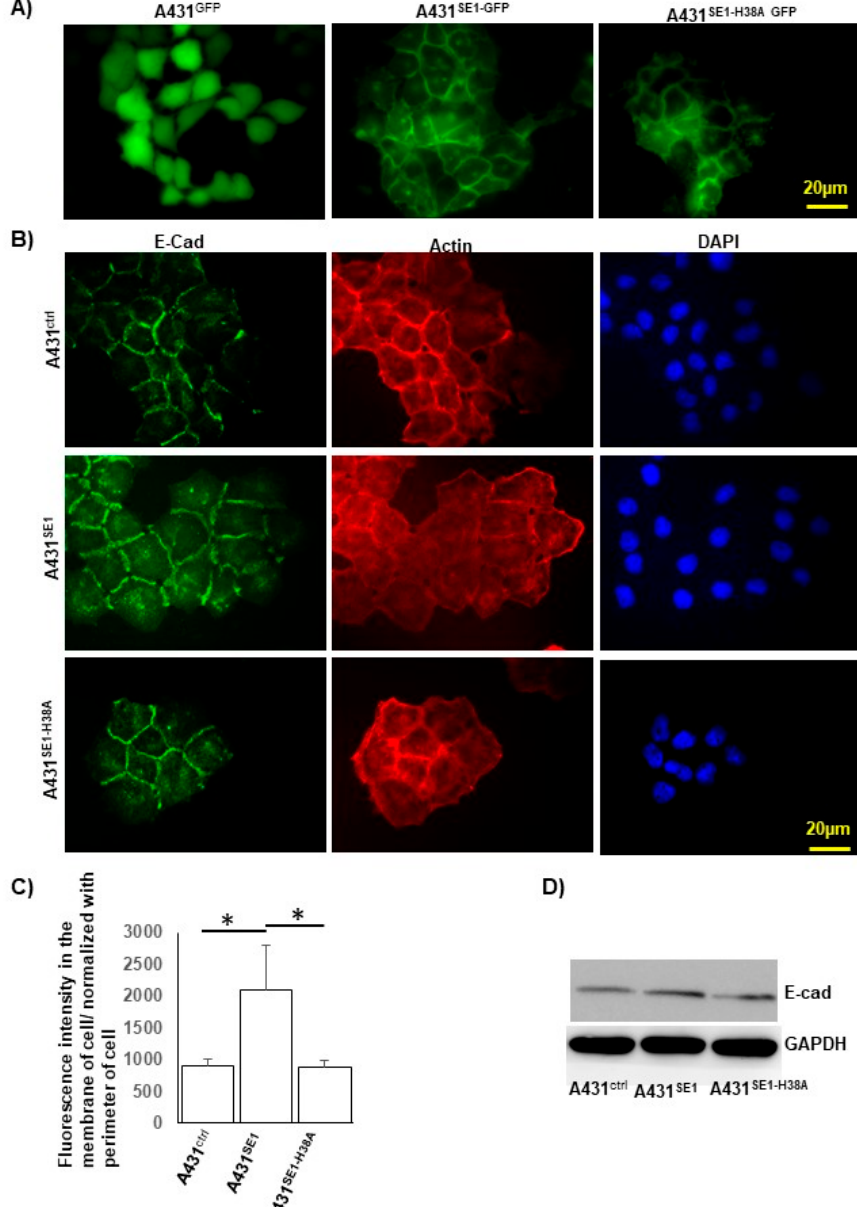
Figure 5. CDC42SE1 localizes at the plasma membrane and enhanced E-cadherin localization to the membrane in A431 SE1 cells. ( A ) A431 cells were infected with lentivirus harboring expression cassette for CDC42SE1-GFP, CDC42SE1 H38A –GFP, and GFP. The infected cells were visualized using a Olympus fluorescent microscope fitted with 40X oil objective. ( B ) A431 Ctrl , A431 SE1 , and A431 SE1-H38A cells were seeded on coverslips, grown to 40% confluency, fixed, and probed with anti-E-cadherin primary antibody followed by Alexa488 secondary antibody. Alexa568-Phalloidin was used to visualize F-actin in cells. Images were taken using 40X objective. ( C ) Quantification of fluorescence intensity of E-cadherin localized in the membrane of A431 Ctrl , A431 SE1 , and A431 SE1-H38A cells. The fluorescence intensity of the cell was normalized with the perimeter of the cells. ( D ) Protein lysate from A431 SE1 , A431 SE1-H38A , and A431 Ctrl were subjected to western blot using antibodies E- cadherin. GAPDH was used as a loading control. (n = 3) (* p ≤ 0.05).